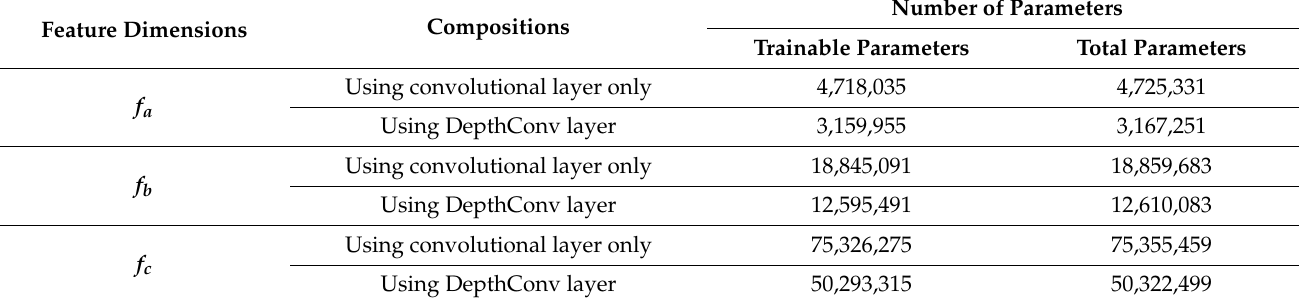
Table 2. Comparison of parameter